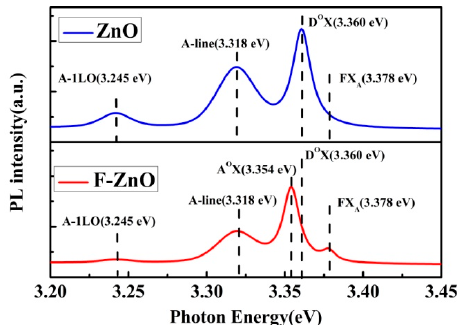
Figure 5. The low temperature PL spectra of ZnO films with and without SF 6 plasma passivation .